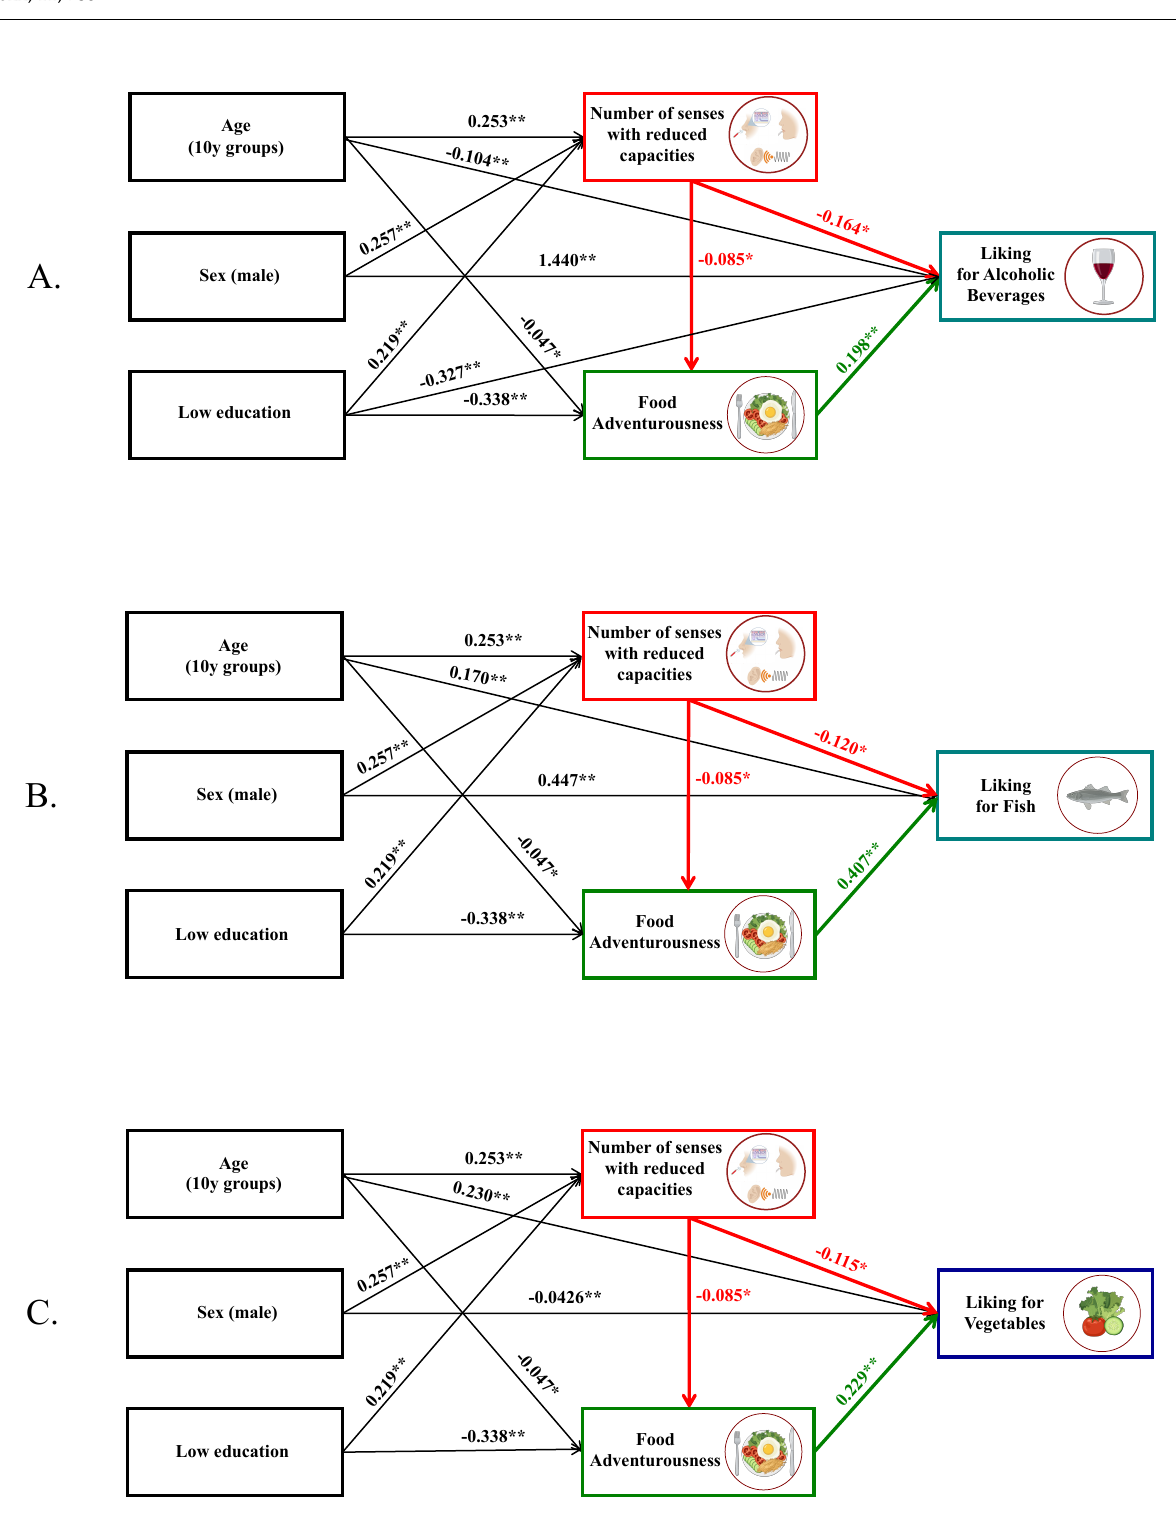
Figure 4. Structural equation models (Lavaan R package [39]) show the effect of the number of senses with reduced capacities on food adventurousness and liking for alcoholic beverages ( A ), fish ( B ), and vegetables ( C ). The models have a good fit (CFI = 0.998, TLI = 0.978, p -value chi-square = 0.134, RMSEA = 0.033 for alcoholic beverages; CFI = 0.998, TLI = 0.973, p -value chi-square = 0.134, RMSEA = 0.033 for fish; and CFI = 0.999, TLI = 0.995, p -value chi-square = 0.286, RMSEA = 0.015 for vegetables). Reported numbers are the effect of the independent variables on the dependent variables. * p value < 0.05, ** p -value < 0.001. y =